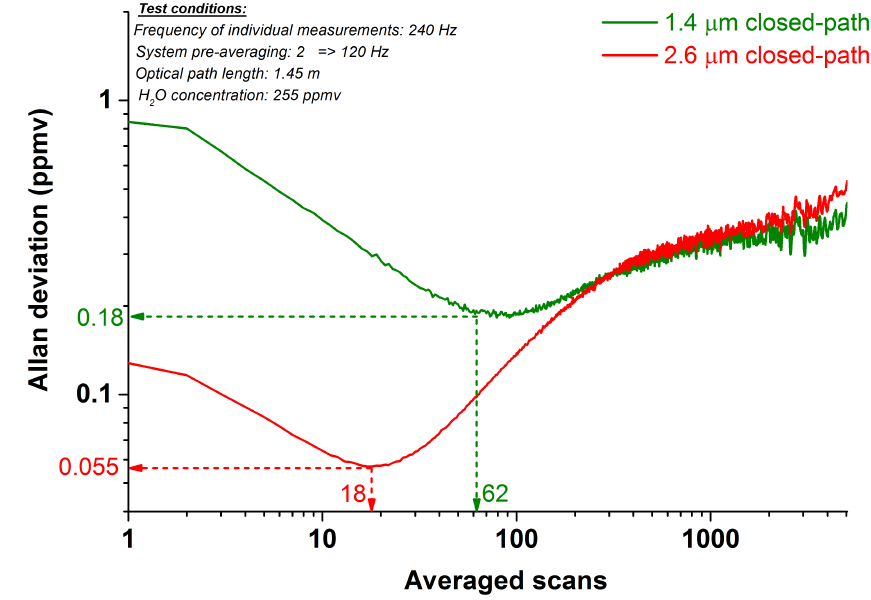
Figure 9. Allan variance plots for both closed-path spectrometer channels. The measurements were done by analyzing gas from a big buffer vessel with a H 2 O concentration of 255ppmv. The optimal precision at 4.8Hz derived from this measurement is 0.22ppmv for the 1.4µm closed-path cell and 0.065ppmv for the 2.6µm closed-path cell. The best – i.e., highest – precision of 0.18ppmv is achieved at 3.8Hz for the 1.4µm cell and 0.055ppmv at 13Hz for the 2.6µm